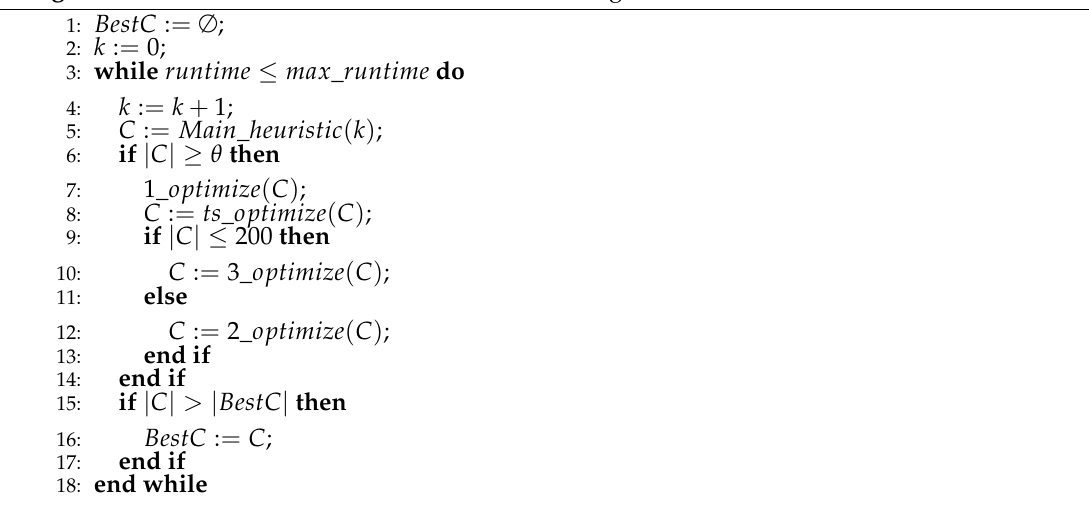
Algorithm 2: Outline of the overall structure of the algorithm